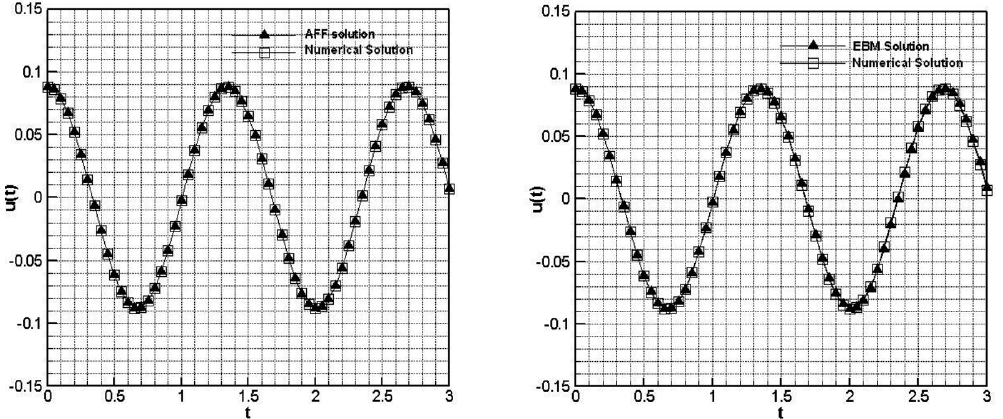
Fig. 6. Comparison of AFF and EBM solution with numerical solution for u ( t ) (case